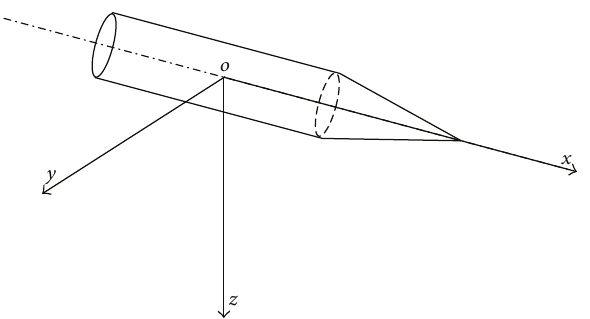
Figure 2: The schematic diagram of the coordinate a ff ected. Trajectory fi ltering based on fl ight measurement